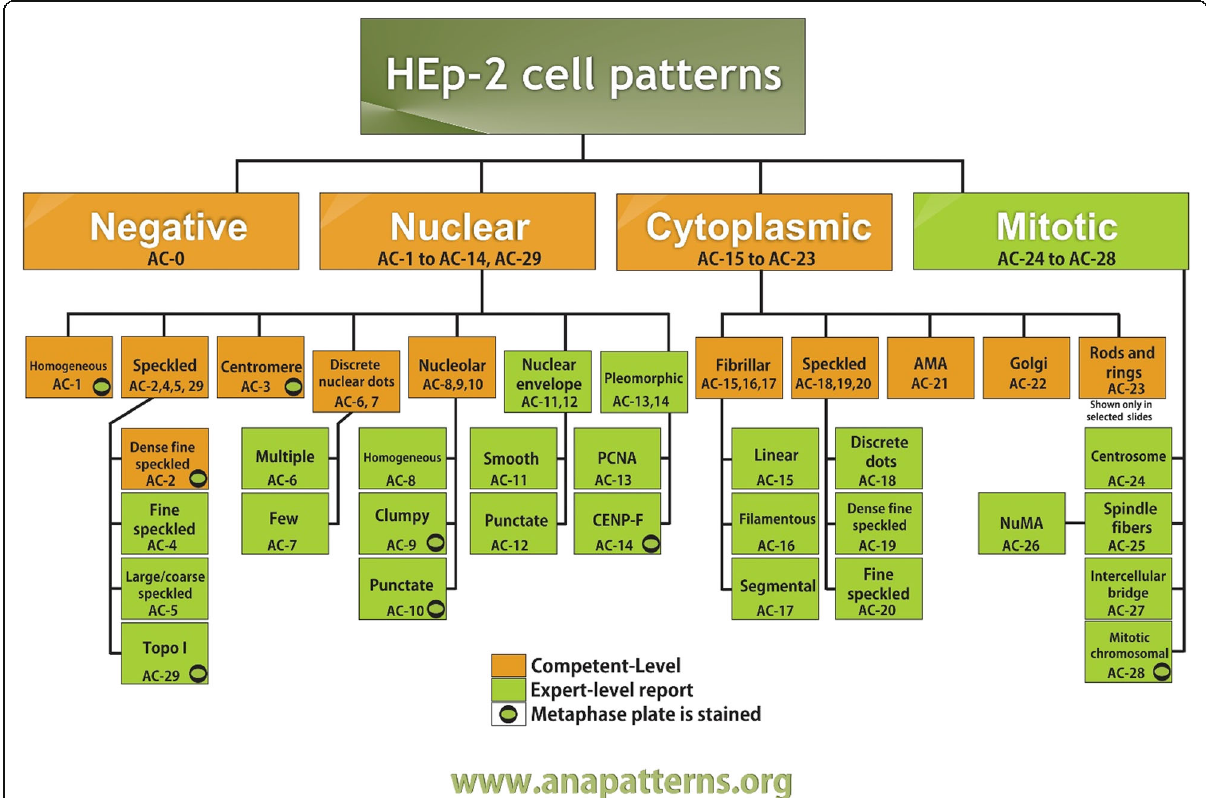
Fig. 1 International Consensus on ANA Patterns classification algorithm